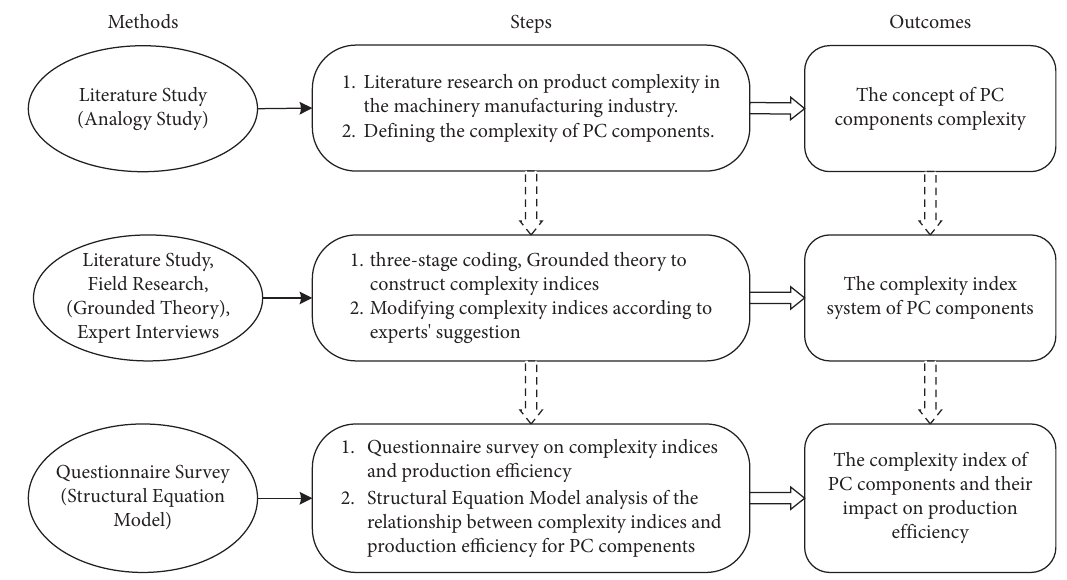
Figure 1: Workflow underlying the research